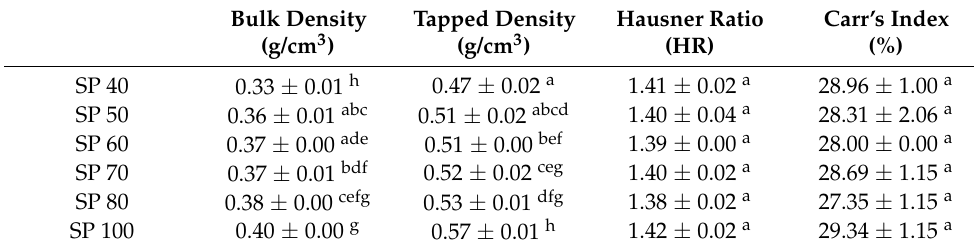
Table 2. Flow characteristics of spray dried waxy rice starches. Values denoted with different alphabets in the same column are significantly different ( p < 0.05).